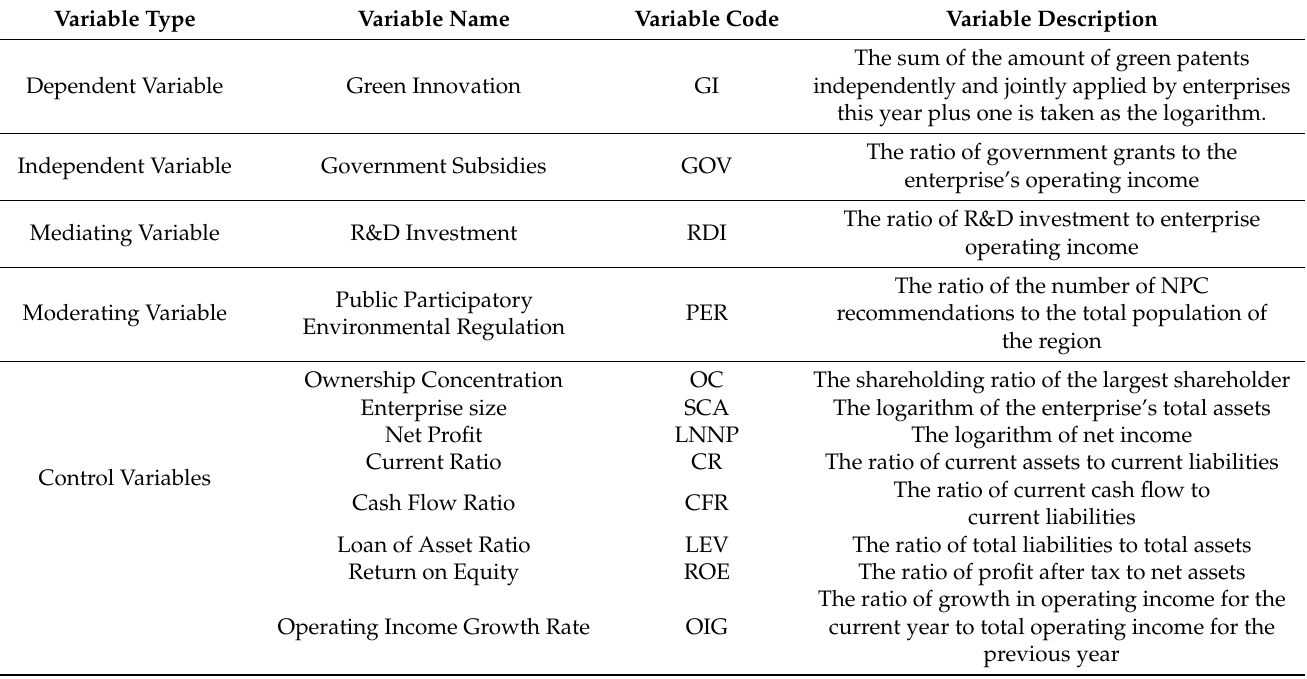
Table 1. Variable definitions and